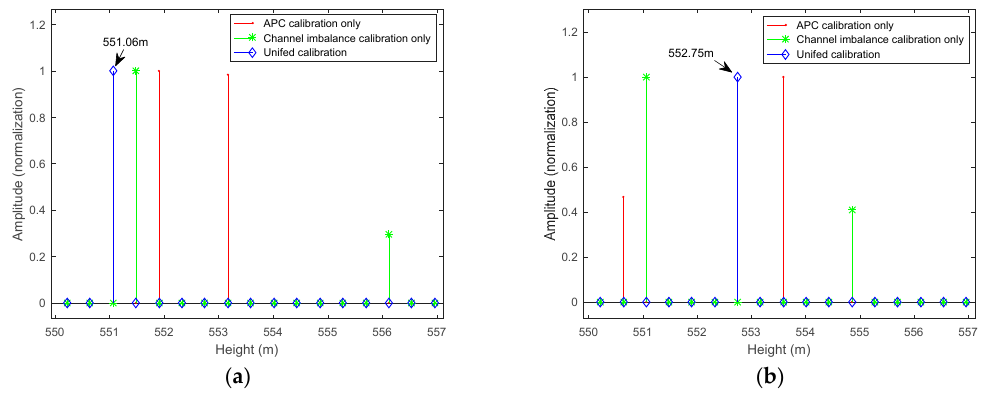
Figure 10. TomoSAR height slices of GCPs. ( a , b ) TomoSAR height slices of GCP1 and GCP2, respectively.